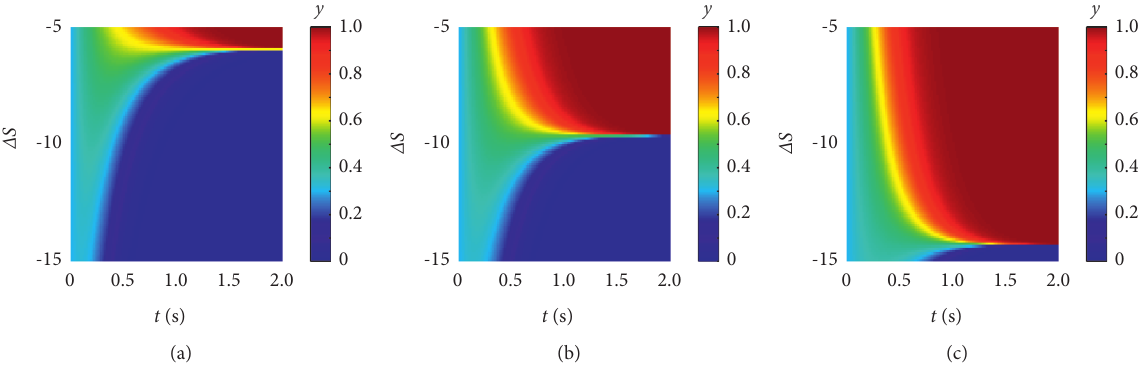
Figure 9: Evolutionary convergence of the proportion of giving way strategy under different Δ S values. (a) α � 0; (b) α � 0 . 5; (c) α �